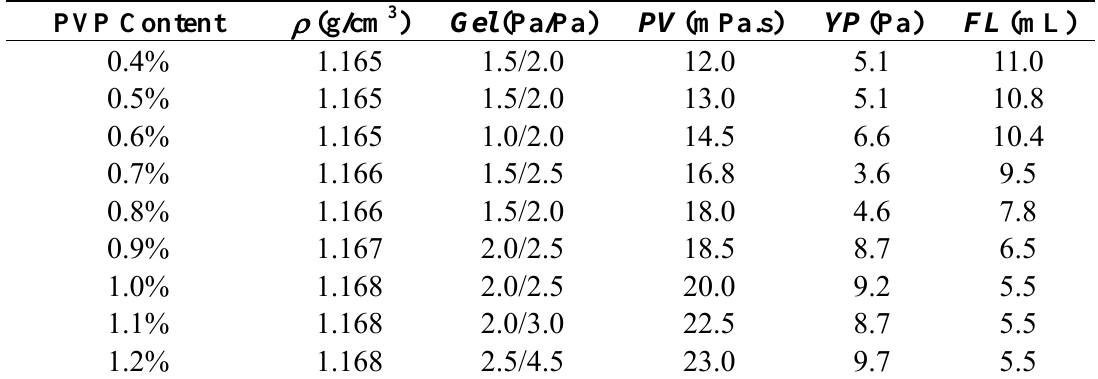
Table 4. The rheological properties of polyethylene-glycol drilling fluid with different PVP K-90